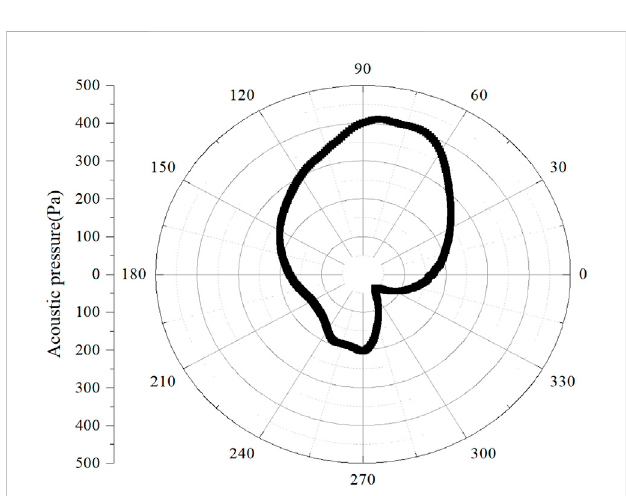
FIGURE 8 Acoustic results for the FW-H equation with closed permeable integral surfaces.